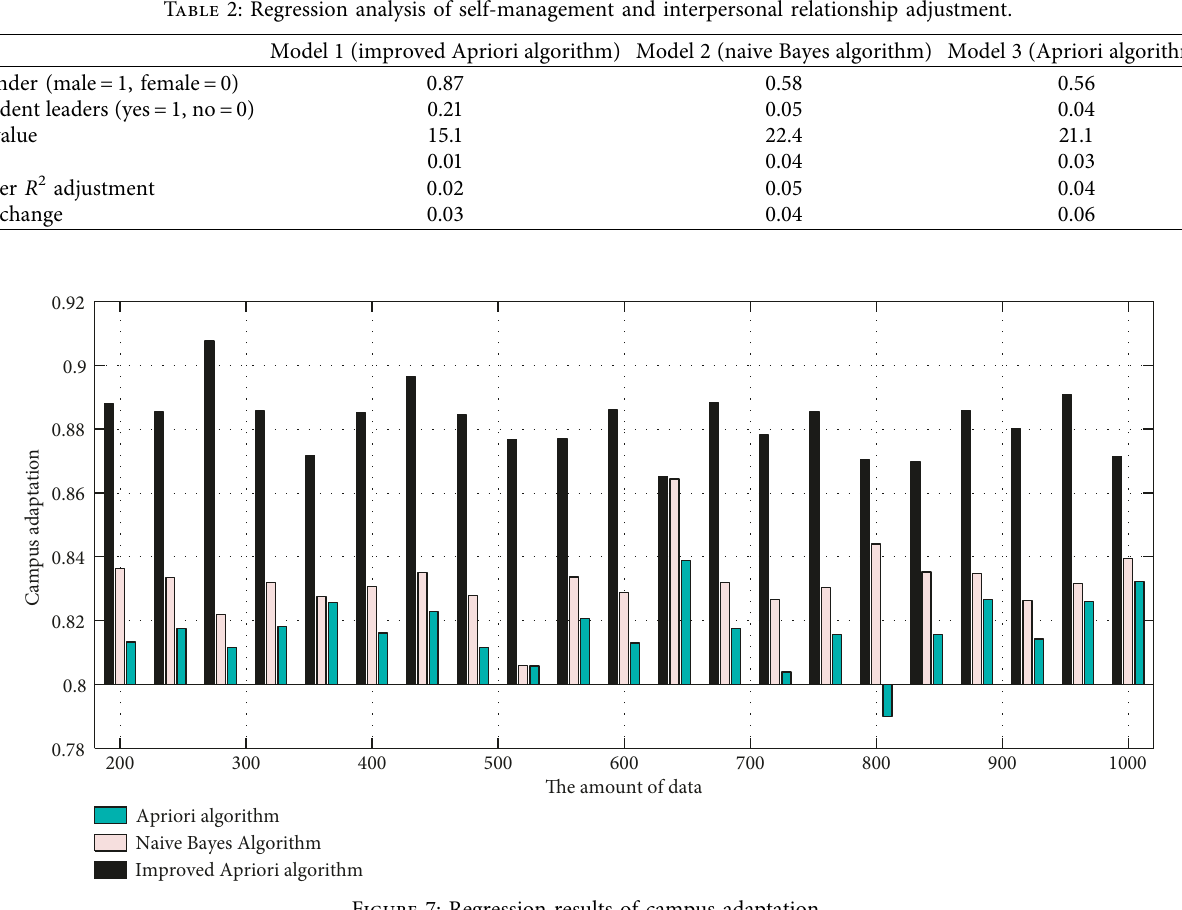
Figure 7: Regression results of campus